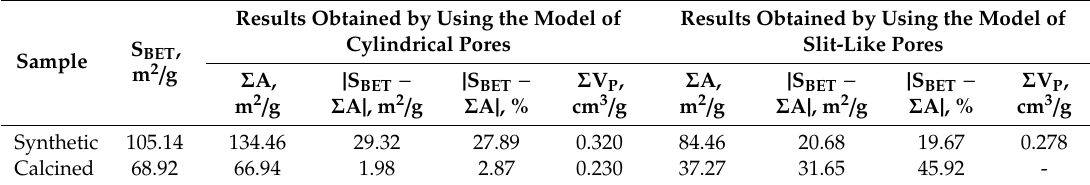
Table 2. D ata of ΣA and ΣV P calculations of samples.